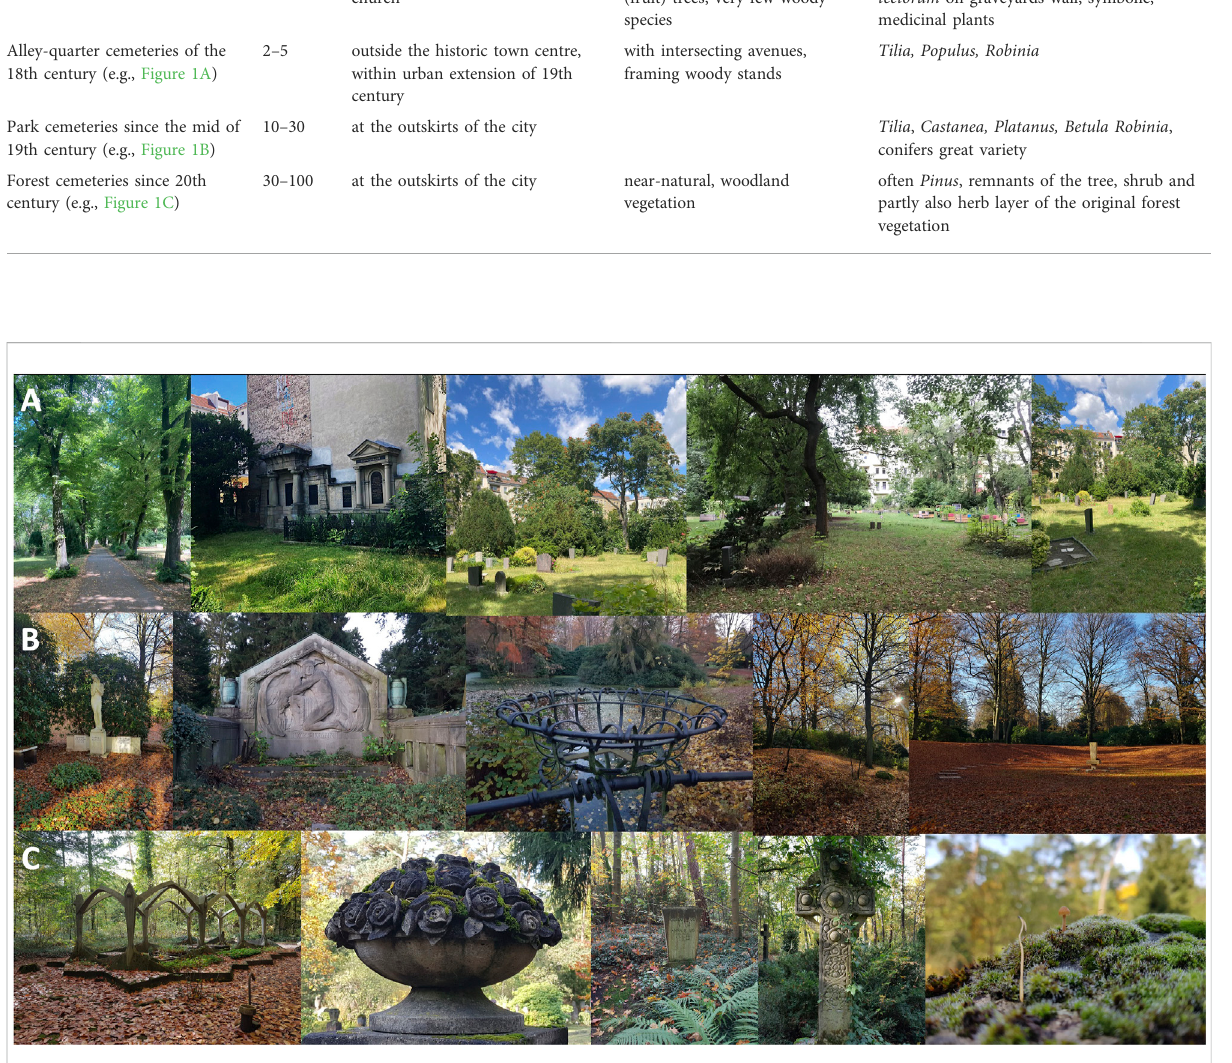
FIGURE 1 Impressions from different cemetery types in Central Europe (see Table 3): (A) Alley-Quarter Cemeteries Berlin Neukölln; (B) the greatest European Park Cemetery Hamburg Ohlsdorf and (C) the Forest Cemetery Stahnsdorf near Berlin. Sources: EdiCitNet, Paula Firmbach (A) ; Sylvia Butenschön (B, C)